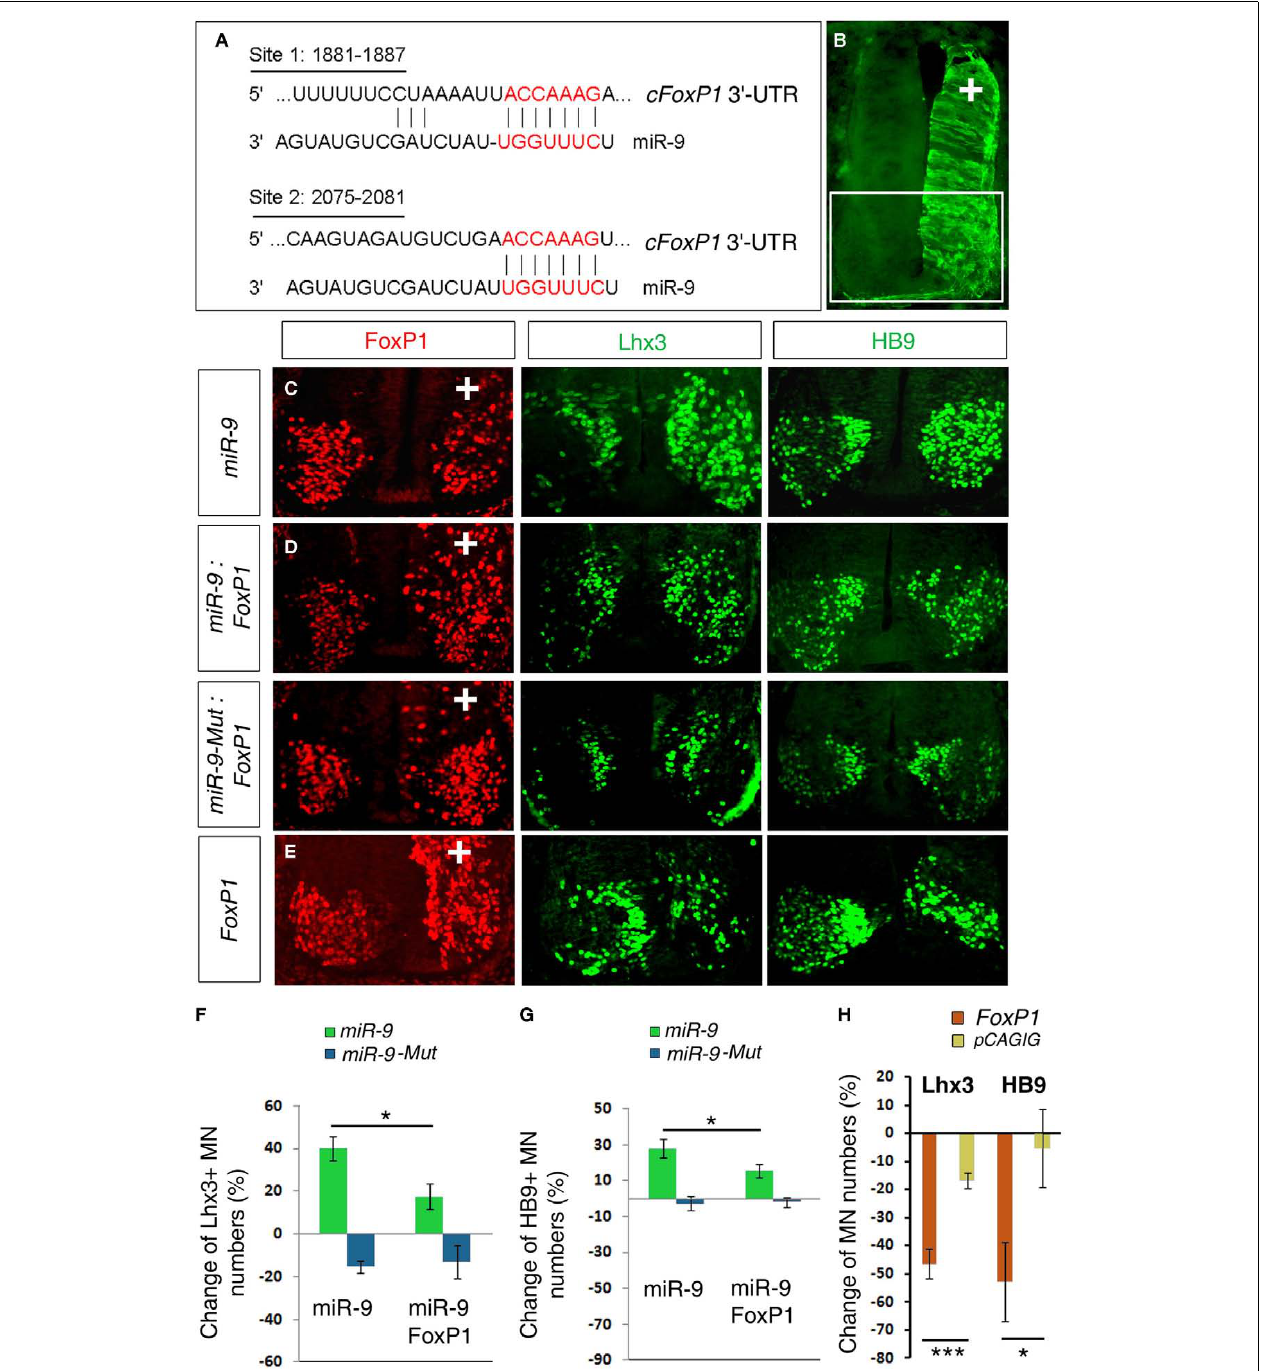
FIGURE 1 | miR-9 regulates MN subtypes by a specific interaction with FoxP1 in chick spinal cords. (A) Schematic of miR-9 binding sites in the 3 (cid:2) -UTR of chick FoxP1 ( cFoxP1 ).The 3 (cid:2) -UTR of cFoxP1 is 3877 nt with miR-9 binding sites at positions 1881 and 2075. (B) In ovo electroporation performed in chick spinal cords at HH stages 10–11 and analyzed at stage 24. The electroporated side can be visualized by a reporter eGFP expression. In all subsequent images the highlighted area in the spinal cord is shown and “ + ” indicates the electroporated side of the spinal cord. (C) Over-expression of miR-9 caused reduced numbers of FoxP1 + and increased numbers of Lhx3 +